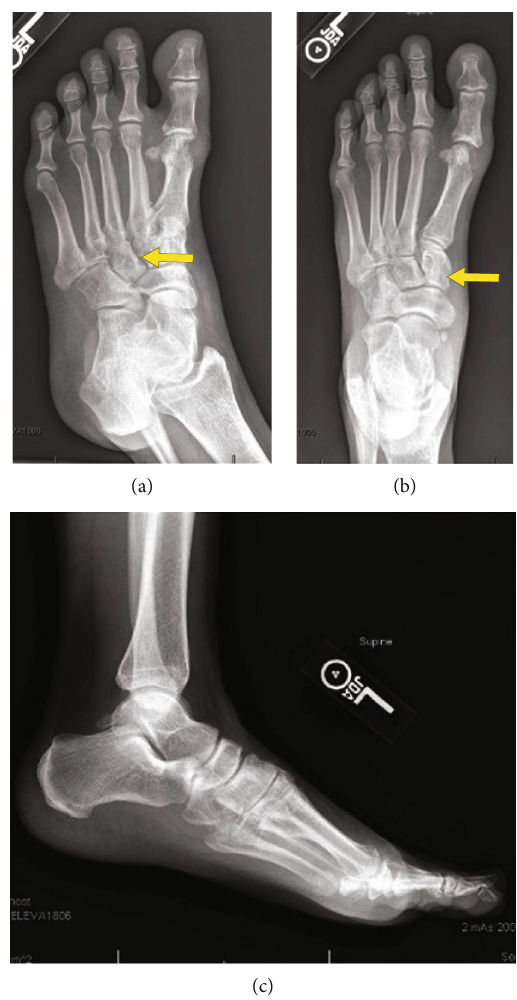
Figure 6: Representative images of a 35-year-old female with D-TGCT in the foot. Large erosion at the medial head of the fi rst metatarsal, and throughout the midfoot, consistent with reported history of D-TGCT from an (a) oblique (arrow), (b) anterior-posterior (arrow), and (c) lateral view with multiple sites of midfoot